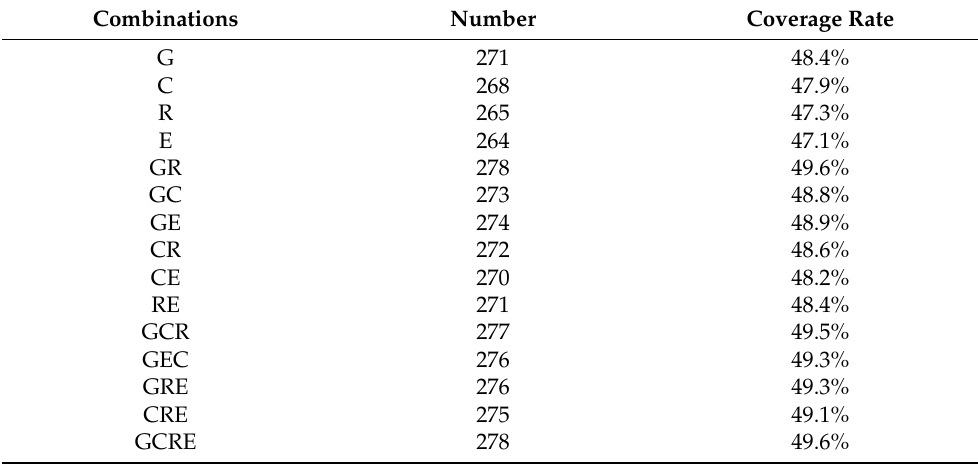
Table 1. Average number of voxels penetrated by sufficient signal rays based on different satellite systems and different combinations during the experimental period.